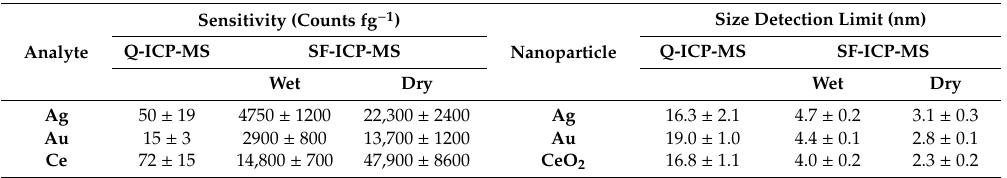
Figure 1. Signal: Noise (blue) and size detection limits (red) as a function of dwell time for: ( A ) a 10 ng L − 1 suspension of CeO 2 NPs (1–10 nm) in Milli-Q water; ( B ) a 10 ng L − 1 suspension of CeO 2 NPs (1–10 nm) in a Milli-Q water containing 10 ng L − 1 of ionic Ce. Signal/Noise was determined by dividing the average intensity of a well resolved peak of a 9 nm CeO 2 NP by the average intensity of the continuous background. All measurements were obtained using SF-ICP-MS and sample introduction via a desolvator. Table 1. Sensitivity for Ag, Au and Ce and the resulting size detection limits for Ag, Au and CeO 2 NPs in Milli-Q water obtained using a quadrupole (Q-) or sector field (SF-) ICP-MS running with (dry) or without a desolvator (wet). A 50 µ s dwell time was used. Means and standard deviations are obtained from analysis on three di ff erent